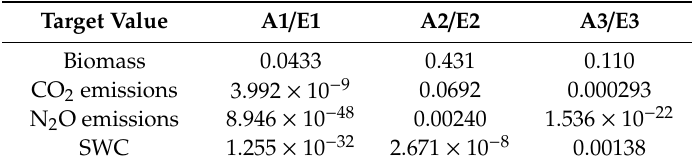
Table A4. p -Values (Mann-Whitney U Test) of aCO 2 / eCO 2 measurements.